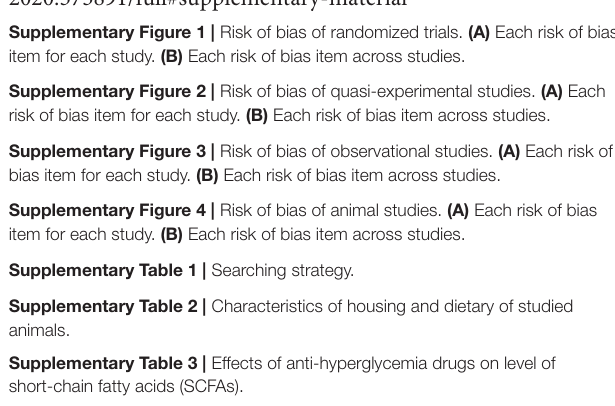
Supplementary Table 4 | Effects of anti-hyperglycemia on bile acid